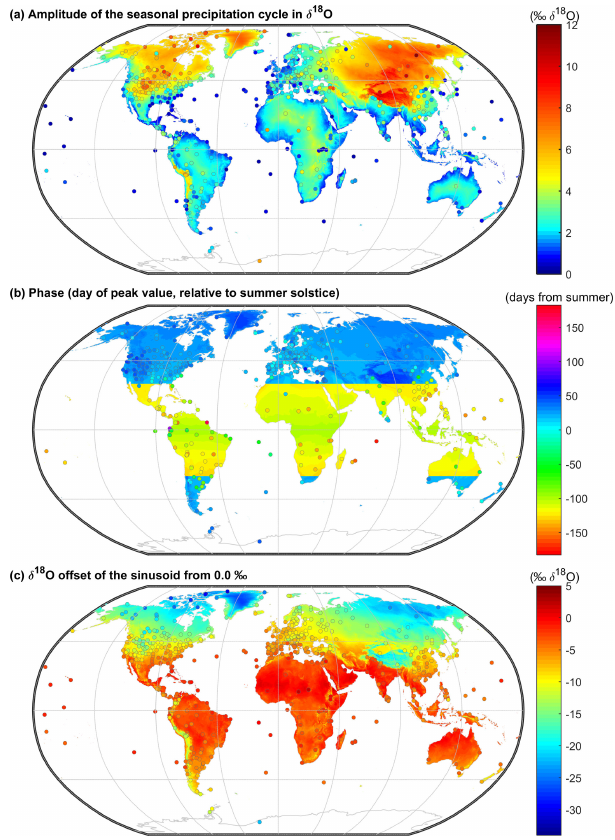
Figure 4. Maps of fitted station values (markers) and regression- based sine-curve parameters (shaded) that describe the seasonal cy- cles in precipitation δ 18 O (a) amplitude, (b) phase, and (c) offset. The shading reflects multiple-regression models based on landscape characteristics, described in Table 2; for phase, separate models were used in absolute latitudes > 30 ◦ versus latitudes < 30 ◦ (see methods). Here, residuals were not yet added back into the model.